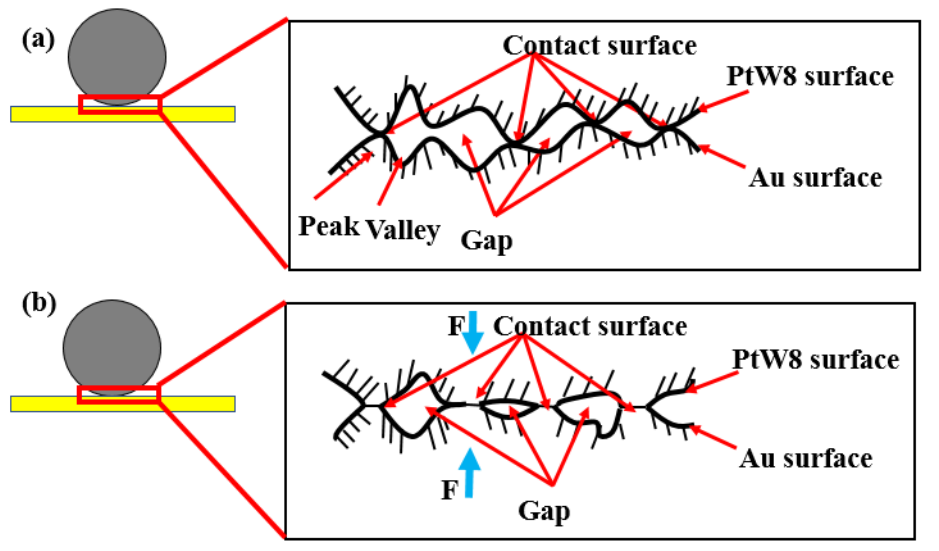
( b ) Figure 10. Stress distribution of the von Mises stress: ( a ) F = 0.2 N and ( b ) F = 0.5 N. 3.3. The Temperature Field of the Parallel-Gap Resistance Microwelding In the process of the PtW8 and Au parallel-gap resistance microwelding, the heat was mainly provided by resistance heat. The equation for resistance heat is as follows: 𝑄 = 𝐼 (cid:2870) 𝑅𝑡 , (2) where I represents the welding current, t represents the welding time, and R represents the total resistance. The total resistance R was mainly composed of the intrinsic resistance of the Mo electrode, PtW8, and Au film, as well as the contact resistance of the contact site. The self-resistance of the Mo electrode, PtW8, and Au film was mainly related to the inherent properties of the conductor, such as